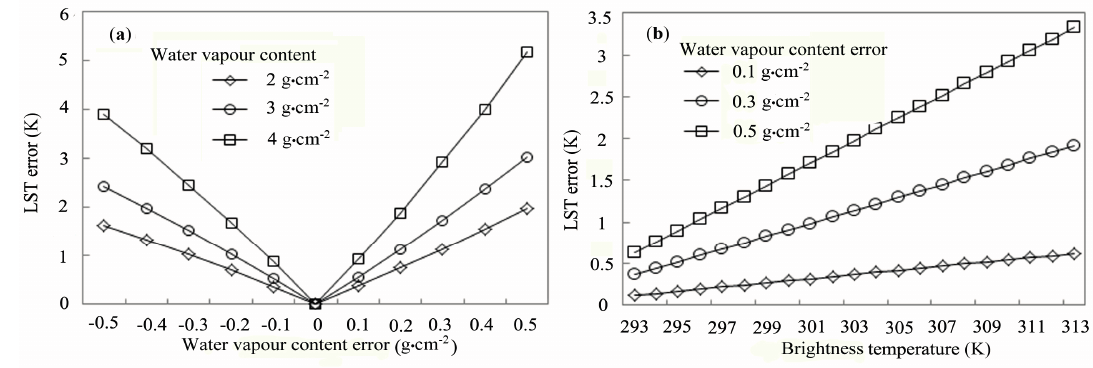
Figure 4. Probable LST estimation error of the IMW algorithm due to the possible error in atmospheric water content estimation. ( a ) Average LST error against possible water content error in Band 10; ( b ) possible LST error against Band 10 brightness temperature for different the water content error of Landsat 8 TIRS data.